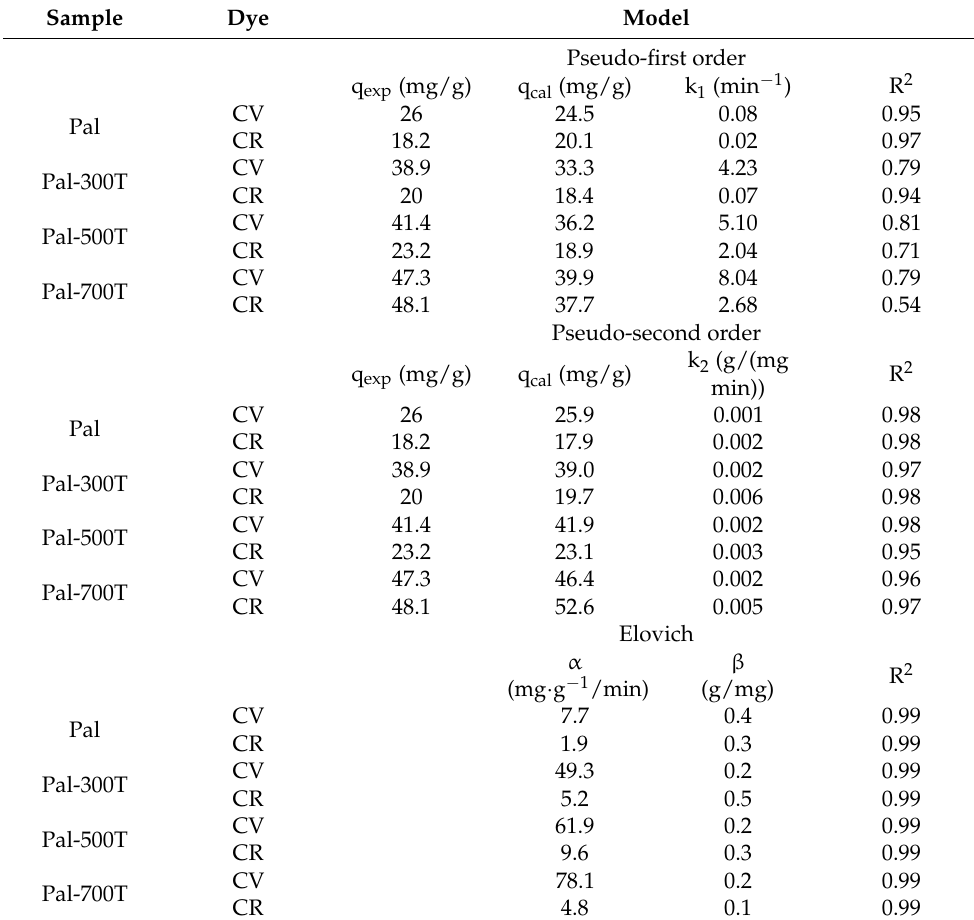
Table 4. Pseudo-first order, Pseudo-second order and Elovich kinetic parameters for CV and CR